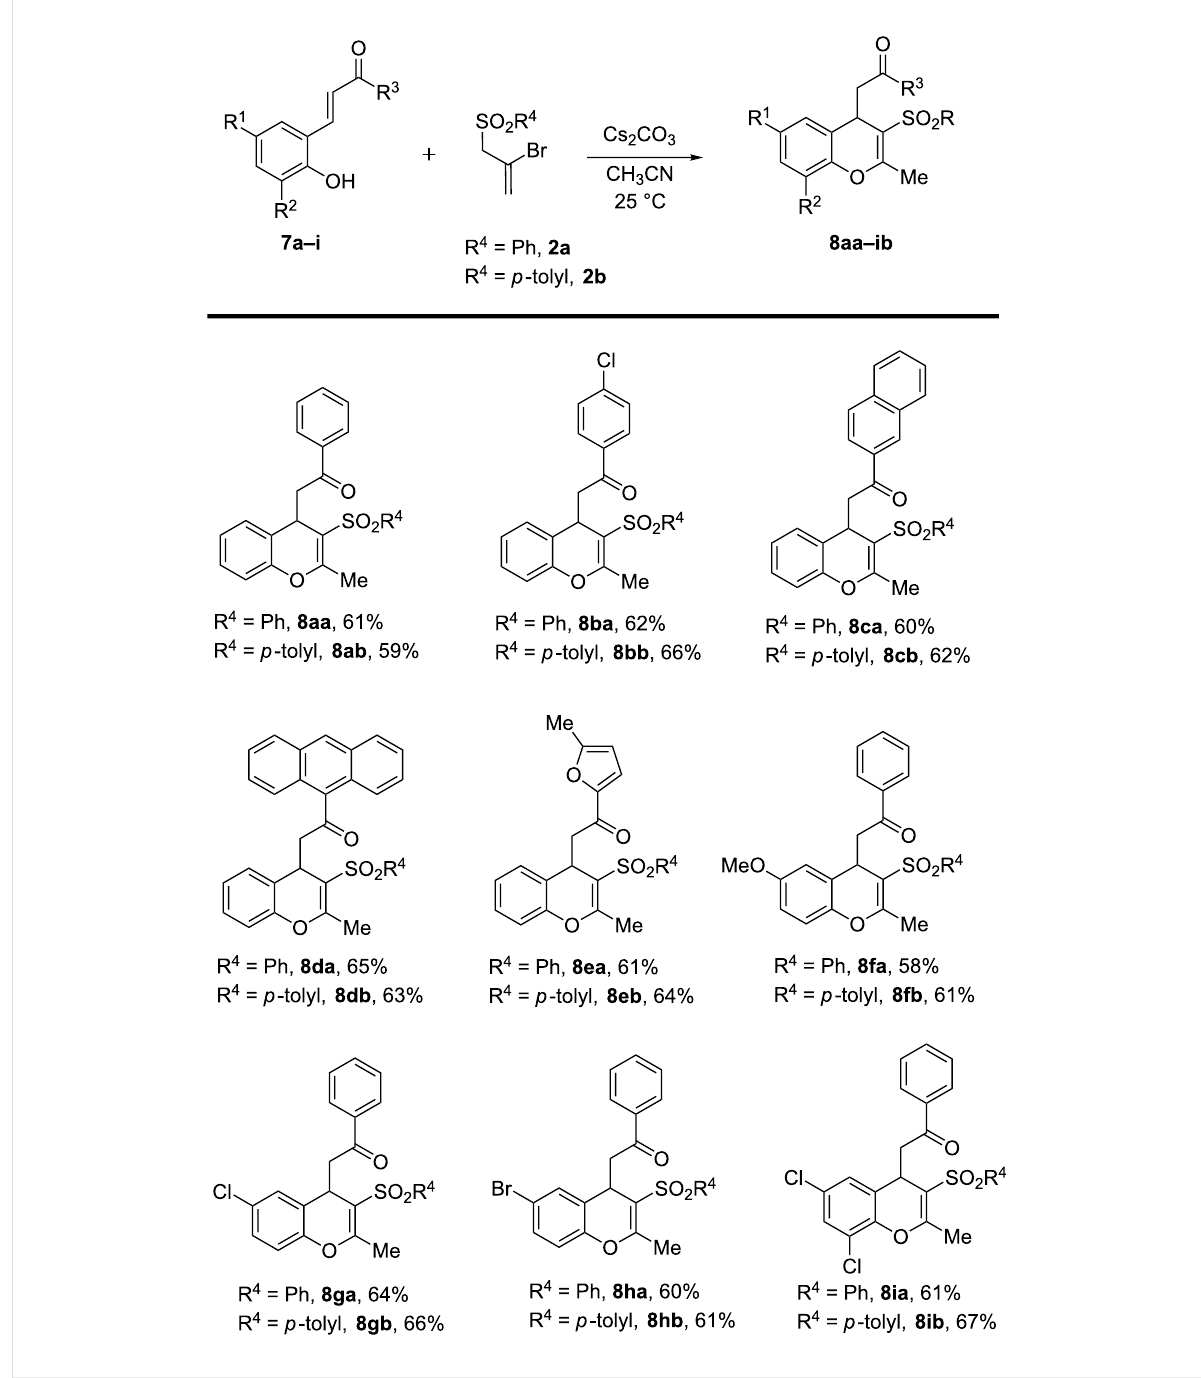
Scheme 4: Synthesis of 4 H -chromenes via base-mediated reactions of 7a–i and 2a,b . Reaction conditions: 7a–i (0.25 mmol), 2a,b (0.30 mmol),